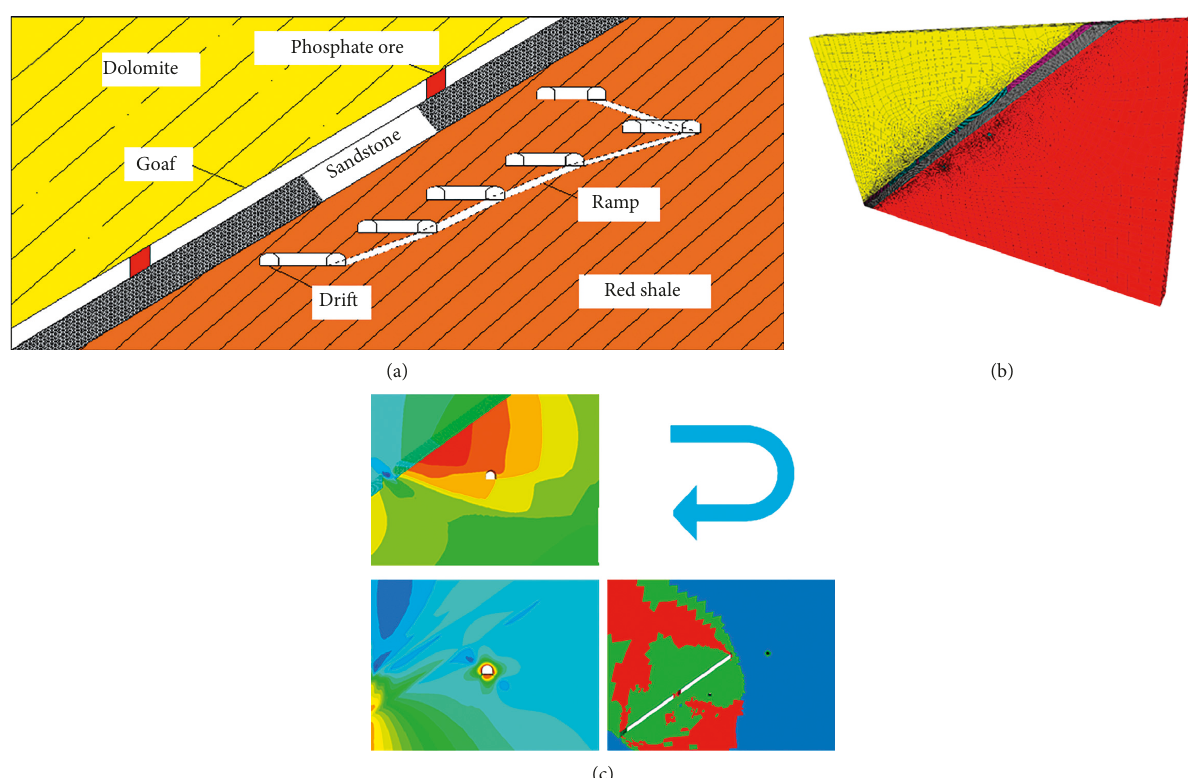
Figure 3: FLAC3D numerical model construction and simulation analysis: (a) the spatial distributions for the components of a stope; (b) the established model; (c) displacement, stress, and plastic zone